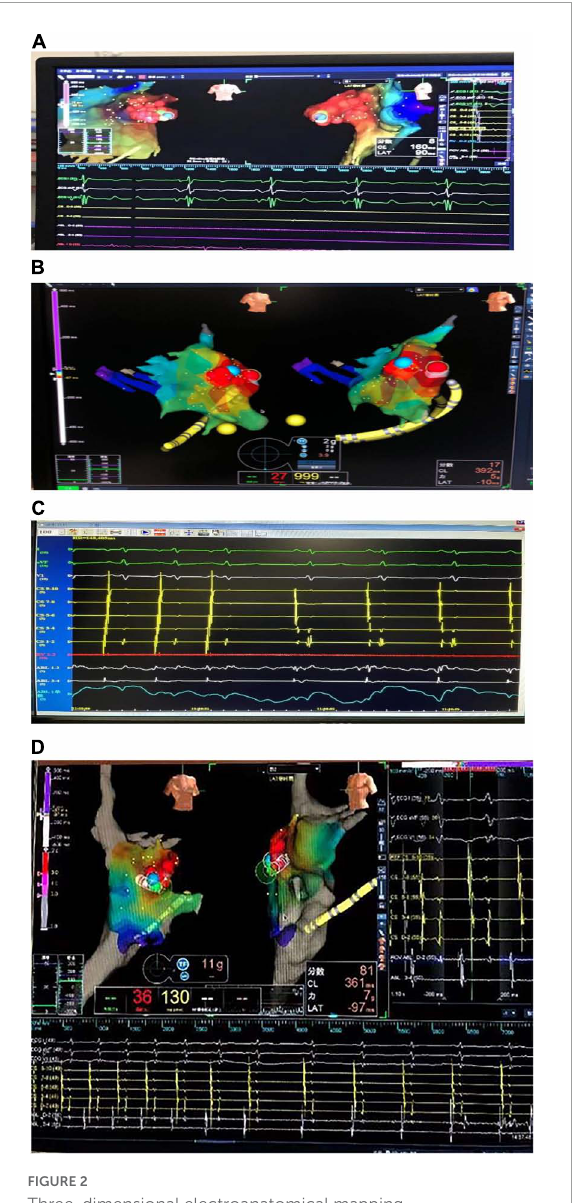
FIGURE2 Three-dimensional electroanatomical mapping. (A) Three-dimensional electroanatomical mapping of case 1 showed the atrial tachycardia (AT) from right atrial appendage (RAA): the earliest excitation point in the red area is the RAA, the red circle is the ablation target, and the blue circle is the best ablation target. (B) Three-dimensional electroanatomical mapping of case 2 showed the AT from left atrial appendage (LAA): the earliest excitation point in the red area is LAA, the red circle is the ablation target, and the blue circle is the best ablation target. (C) The electrogram of the target site of case 2: during the ablation, the atrial activation sequence was changed from CS1-2 to CS9-10 to CS9-10 to CS1-2. (D) Three-dimensional electroanatomical mapping of case 3 showed the AT from RAA: the earliest excitation point in the red area is the RAA, the red circle is the ablation target, and the blue circle is the best ablation target. The sequence of atrial activation did not change significantly, but the shape of the A wave and the AA interval was changed. AT, atrial tachycardia; LAA, left atrial appendage; RAA, right atrial